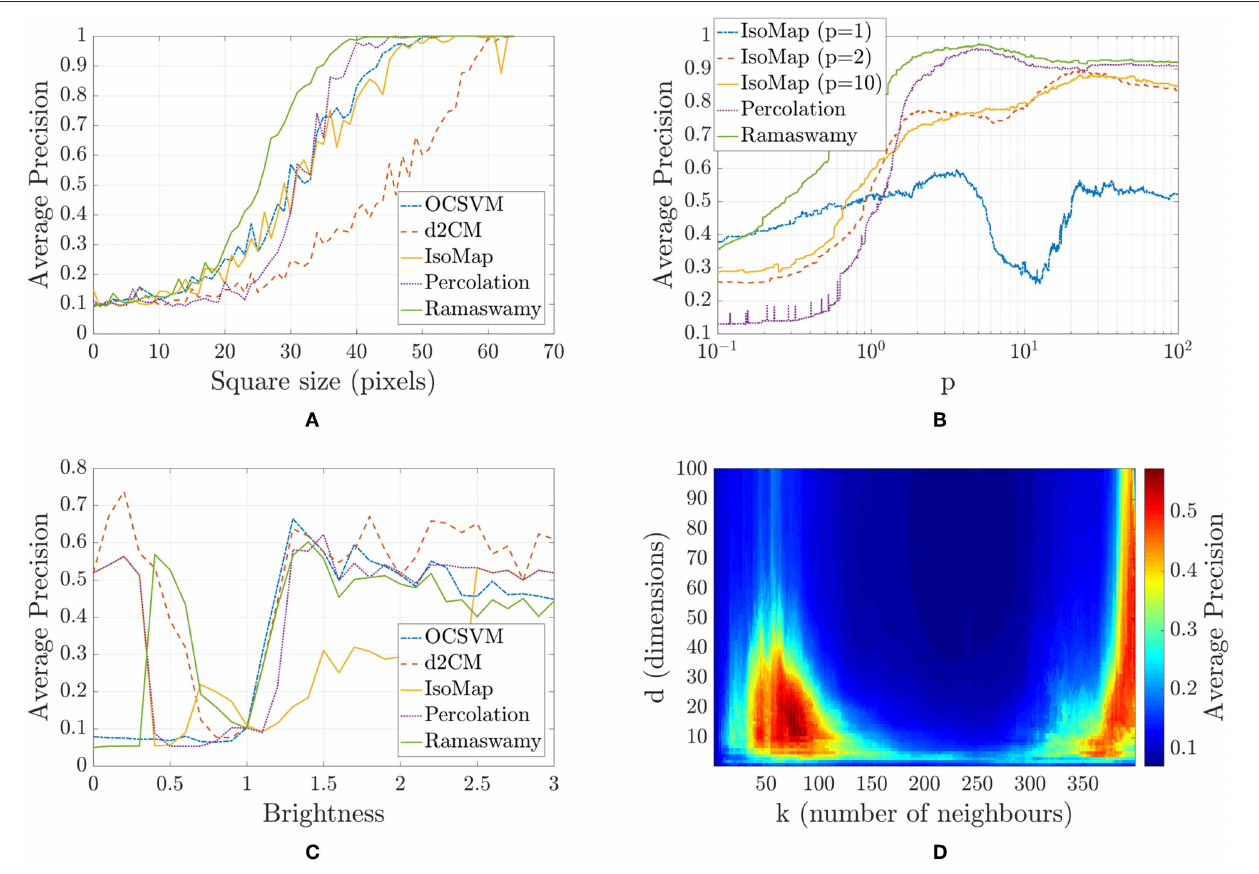
FIGURE 5 | Analysis of the face database. (A) Average precision as a function of the square size for the different outlier finding methods, One Class Support Vector Machine (OCSVM) in blue, distance to center of mass (d2CM) in orange, IsoMap in yellow, Percolation-based method in purple, and Ramaswamy in green. The Average precision was calculated on databases independently generated from those used to set the parameters of the methods. (B) Average precision as a function of the distance measure for different outlier finding methods with a square size of 36 pixels, IsoMap (trained with p = 1) in blue, IsoMap (trained with p = 2) in orange, IsoMap (trained with p = 10) in yellow, Percolation-based method in purple, and Ramaswamy in green. The Average precision was calculated on databases independently generated from those used to set the parameters of the methods. (C) Average precision as a function of the brightness multiplier of the outliers. (D) Average precision in the training set as a function of the IsoMap parameters with a square size of 30